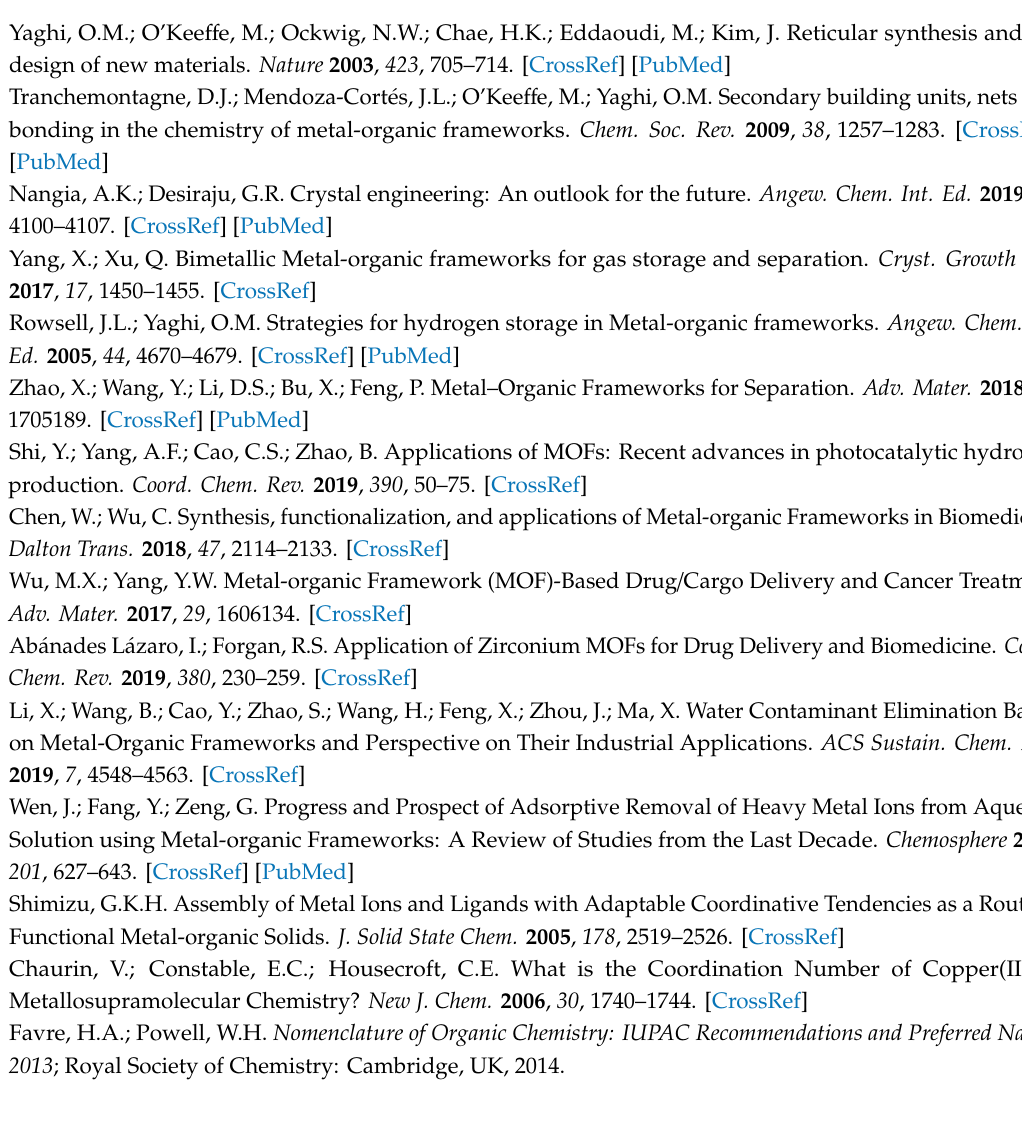
Figure S1 Electrospray mass spectrum of 2 ; Figures S2–S5: NMR spectra of 2 ; Figures S6–S9: powder X-ray di ff raction